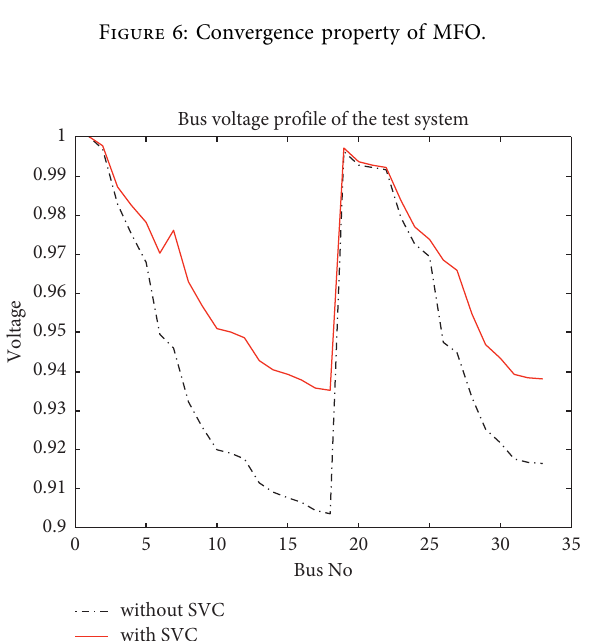
Figure 7: Voltage profile of 34-bus system with MFA.